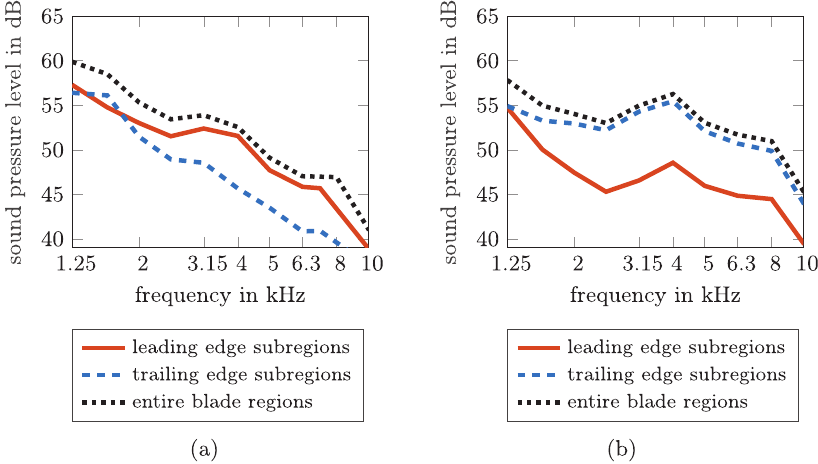
_ V ¼ 1 : 1 m 3 s (cid:1) 1 and fan rotational speed